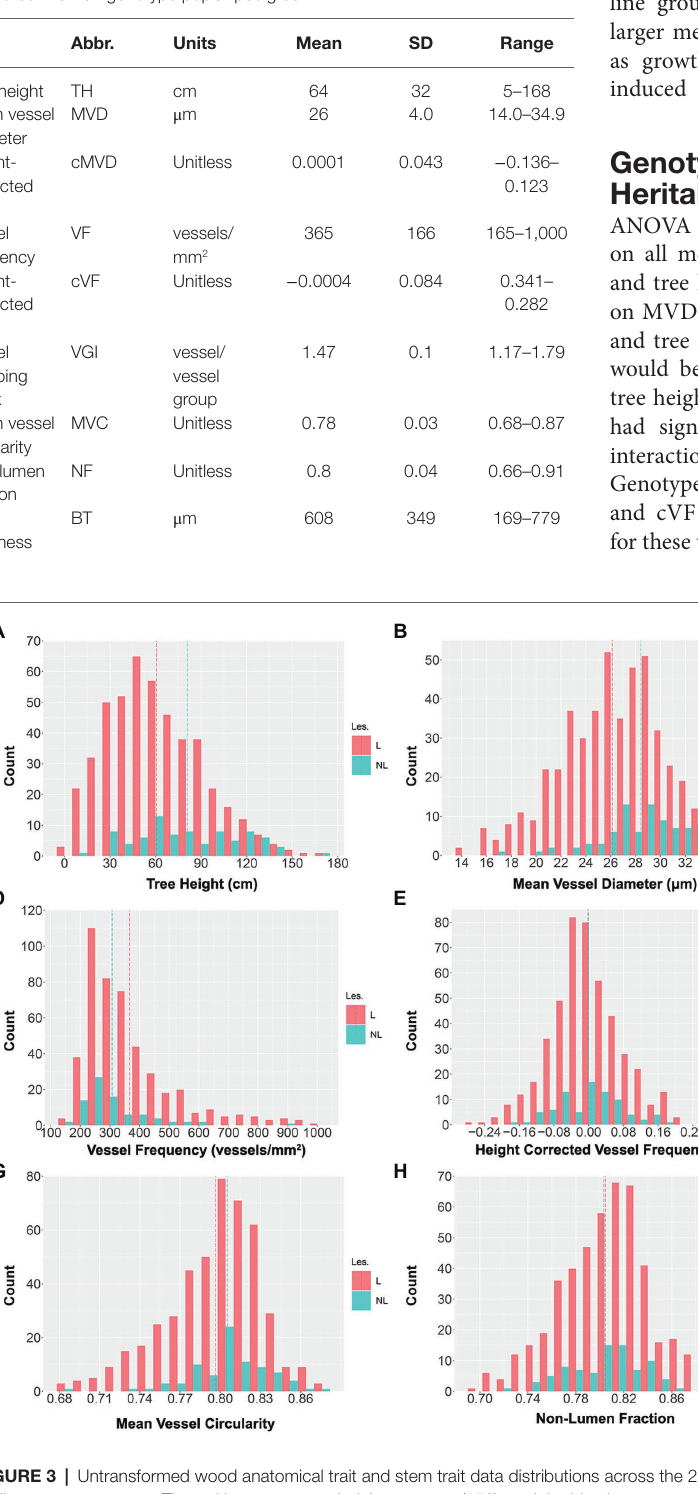
TABLE 1 | The means, standard deviations (SD), and ranges of phenotypic traits measured in a 201 genotype poplar